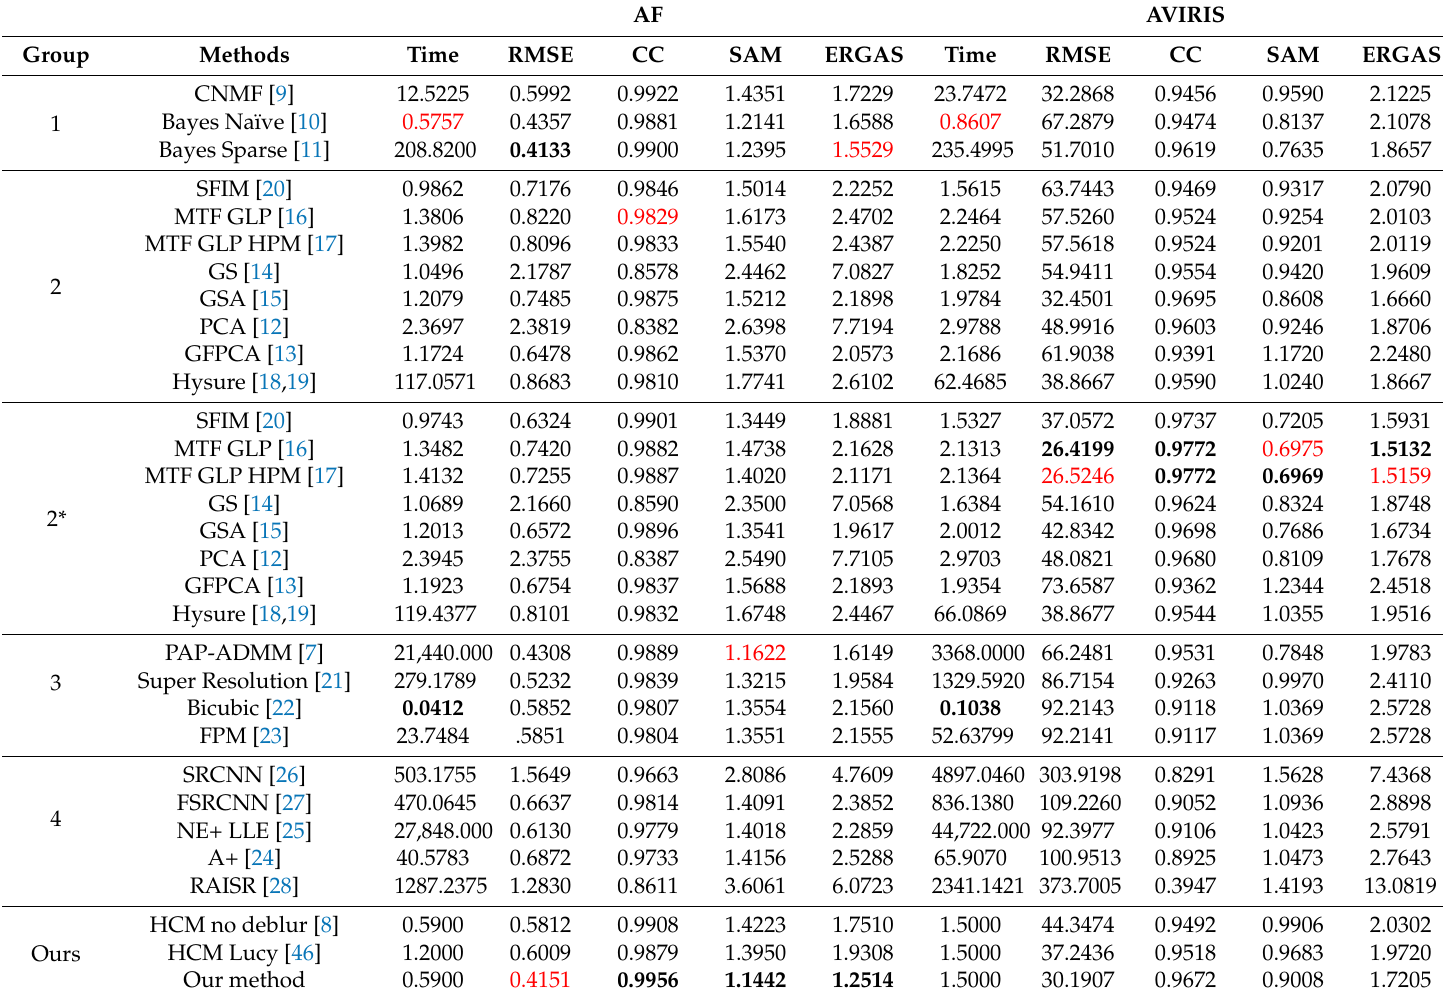
Table 2. Comparison of our methods with various pansharpening methods on AF and AVIRIS. Bold numbers indicate best performers for each metric. Red numbers indicate second best